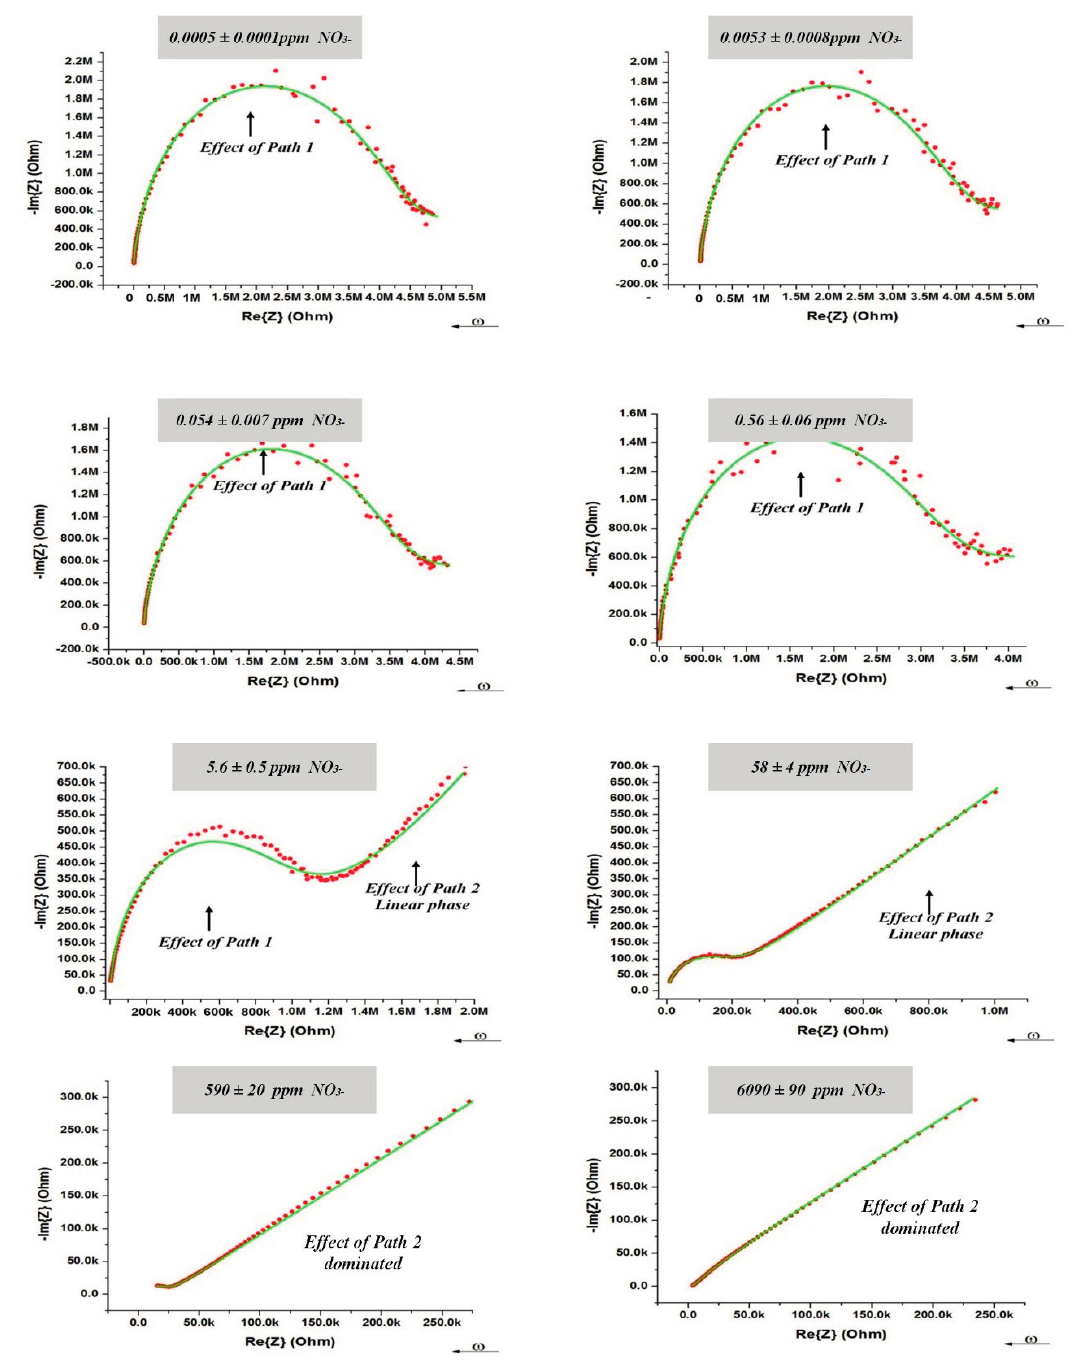
Figure 4. (Red dots) Nyquist response at 200 mV of the PVC-BEHP electro-chemical nitrate sensor through wide a range of nitrate (NO 3 − ) concentrations. (Green lines) Fitting